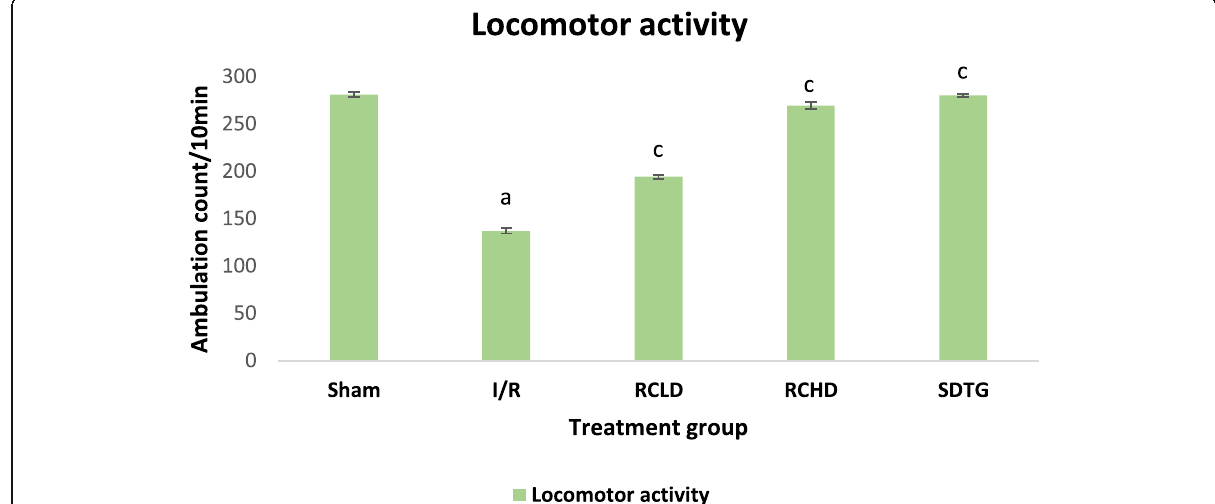
Fig. 3 Behavioral parameter estimation (locomotor activity) in the different treatment groups. Where, values are indicated as mean ± SEM; ( n = 5) in each group. Data were subjected to one-way ANOVA followed by Dunnett ’ s test when RCLD, RCHD, and SDTG groups were compared to the I/R group, while the I/R group was compared to the Sham group. a p < 0.01, when compared to Sham Group, c p < 0.01 when compared